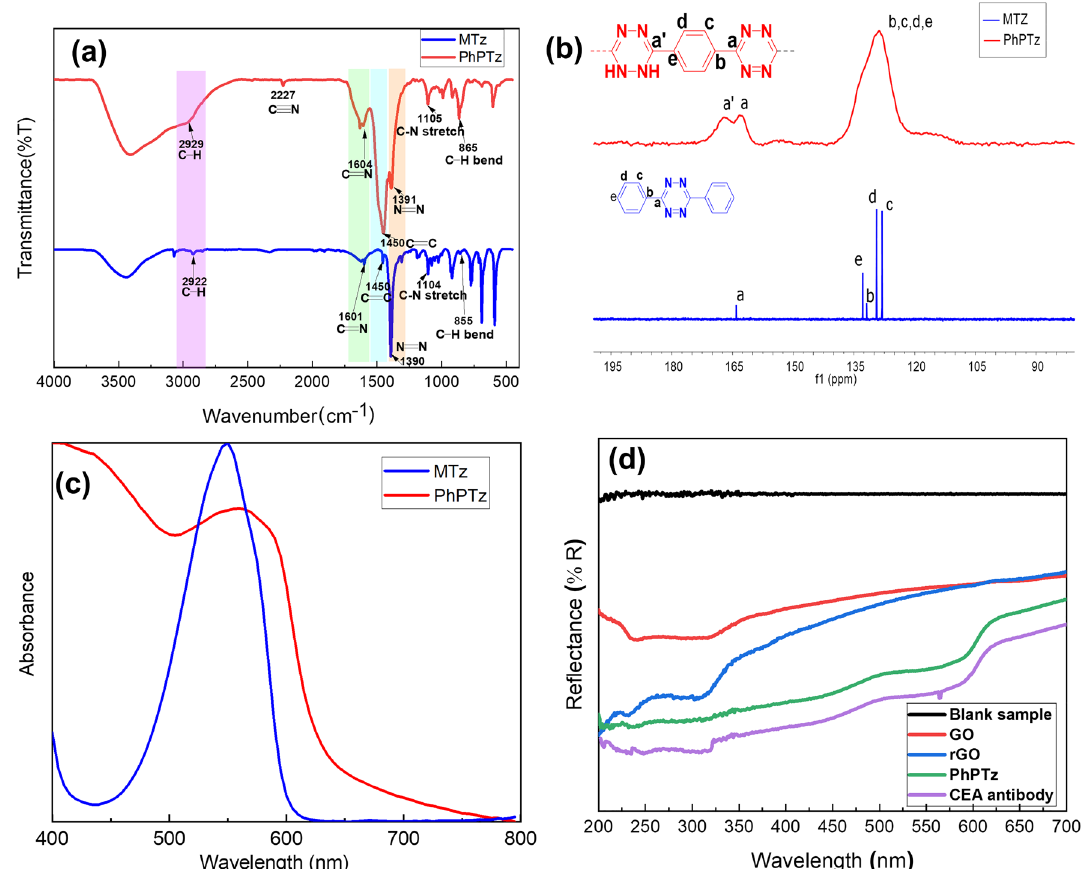
Figure 3. IR and NMR characterization of polymer: comparison of ( a ) IR spectra, ( b ) 13 C NMR spectra of tetrazine polymer (PhPTz) and the model compound (MTz); ( c ) Comparison of the diffuse reflectance spectrum of PhPTz and the solution state absorption spectrum of MTz; ( d ) UV–Visible reflectance spectra of blank sample (only glass), GO, rGO, PhPTz, and anti-CEA/PhPTz/rGO thin